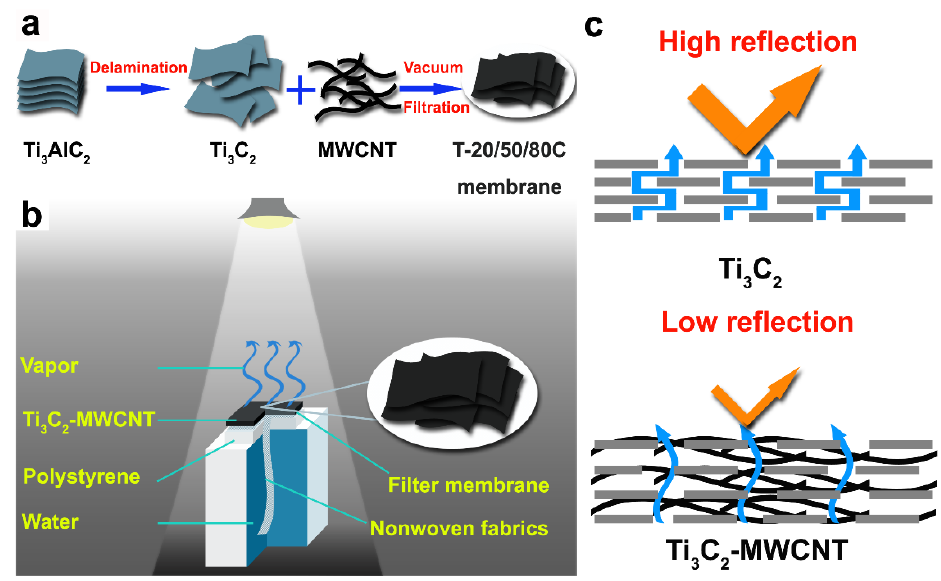
Figure 1. Scheme of ( a ) fabrication processes of the Ti 3 C 2 -MWCNT membranes, ( b ) the solar evapo- rator and ( c ) light reflection and vapor flux.